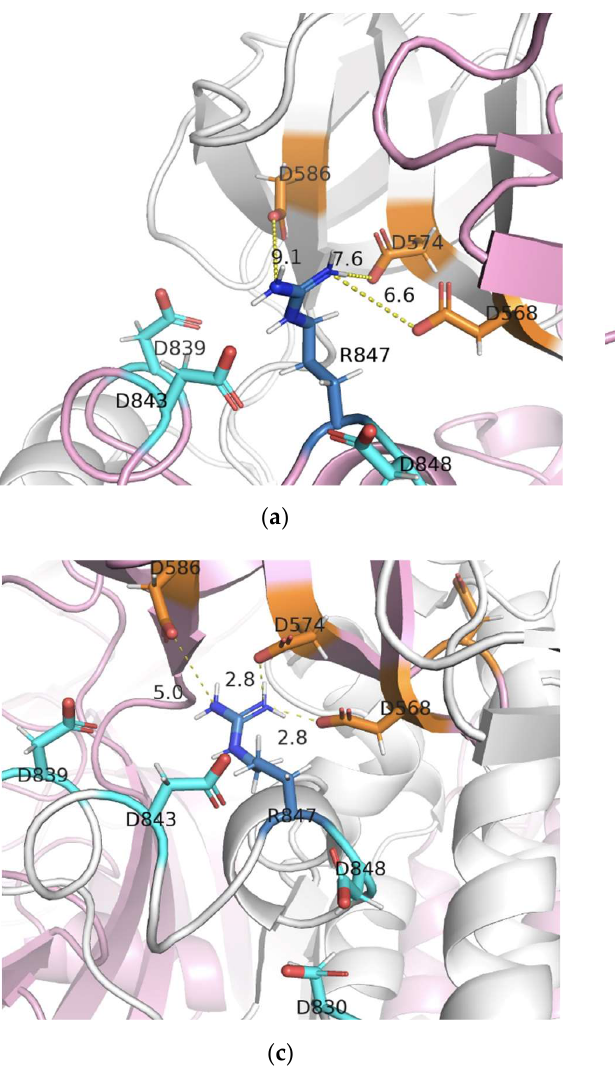
Figure 5. Arg847 (shown in blue) of the S-protein protomer of SARS-CoV-2 in the “open” ( a , b ) and the “closed” ( c , d ) states and its environment. Aspartate residues belonging to the same S-protein protomer as Arg847 are colored in cyan, aspartate residues belonging to the adjacent S-protein protomer are colored in orange. The protomer of S-protein in the “open” state is colored in pink, the adjacent protomer in the “closed” state in white. Plates ( b , d ) show possible positions of MB molecules relative to the spike protein. MB molecules are rendered by sticks and colored in yellow. The dashed yellow lines show distances between some contacting amino acid residues.